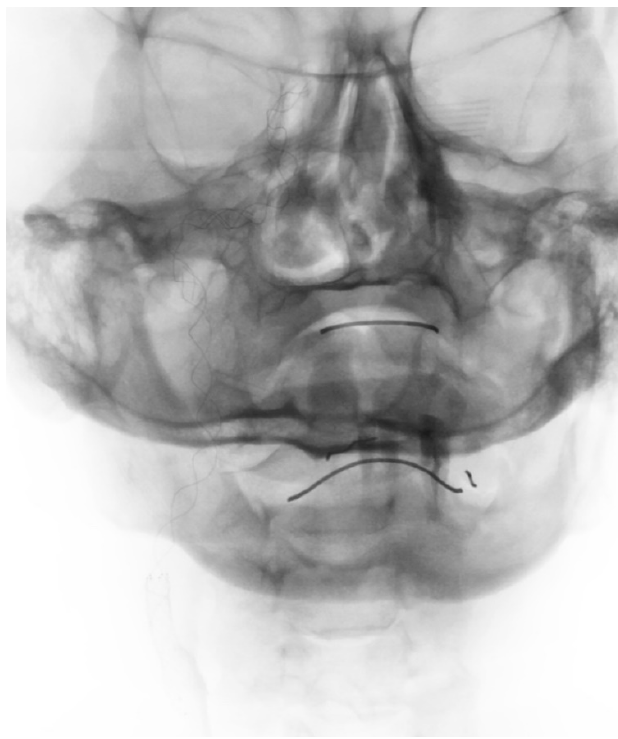
Figure 4. Four overlapping stents covering dissected ICA segments (non-subtracted image).